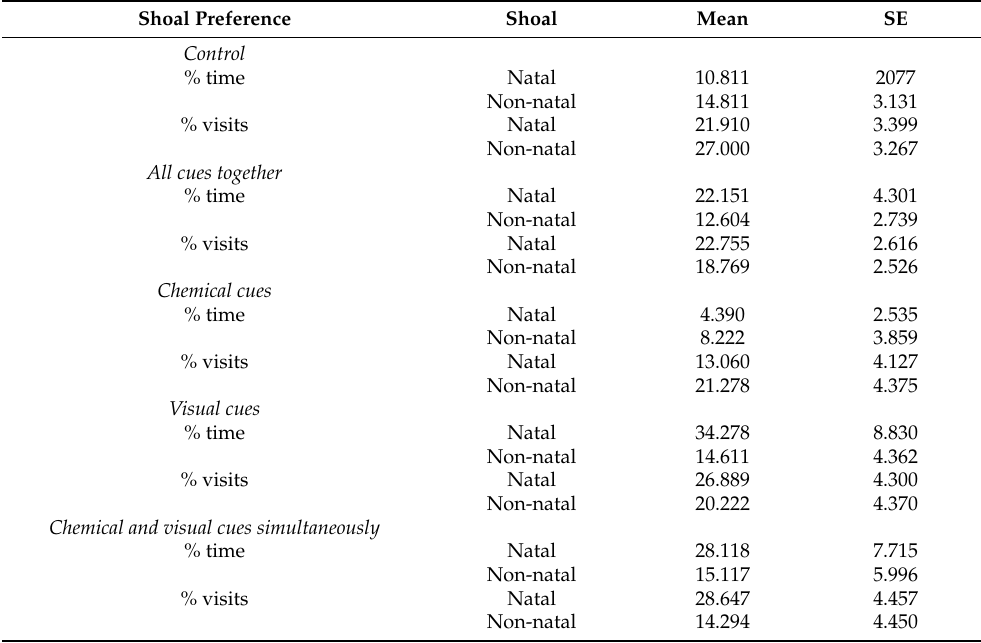
Table 1. Summary of the mean and the standard error (SE) for each of the tests performed.